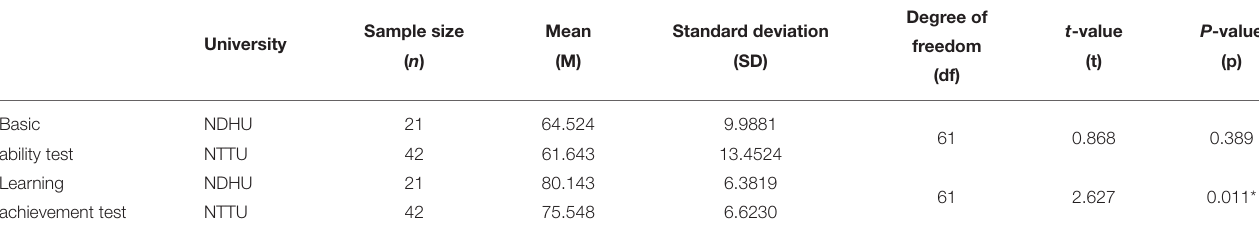
TABLE 2 | Summary of t -test results of the two school students’ score before and after the